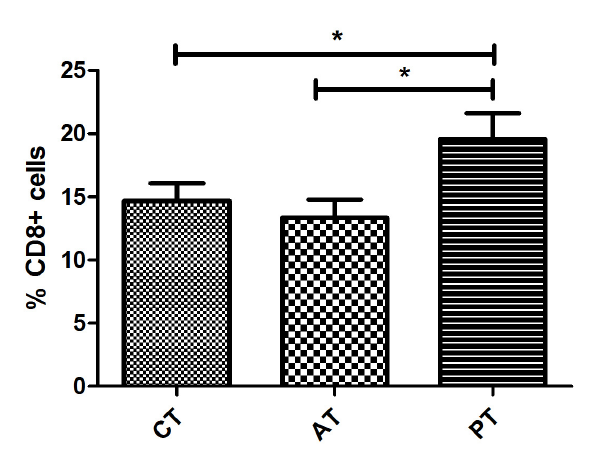
Figure 1. Proportion of cytotoxic T cells (CD8+) in the peripheral blood of controls (CT), patients with active lesion (AT), and patients after chemotherapy (PT). Differences between groups were considered significant when p < 0.05 and are indicated by asterisks